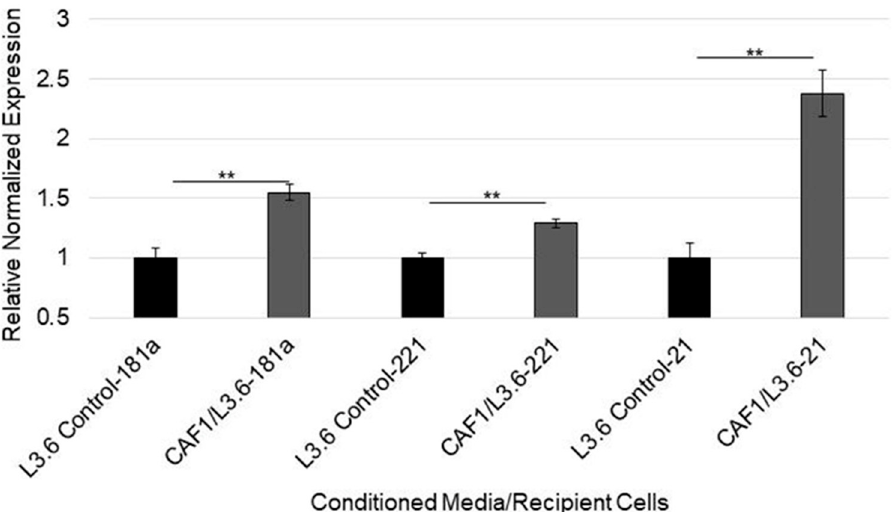
Figure 4 . Expression of PTEN-targeting miRs in cells exposed to CAF-conditioned media. L3.6 epi- thelial cells were cultured in DMEM or gemcitabine-treated CAF-conditioned media for four days. Expression of microRNAs within recipient L3.6 cells was thereafter quantified via RT-PCR. ** p < 0.01.